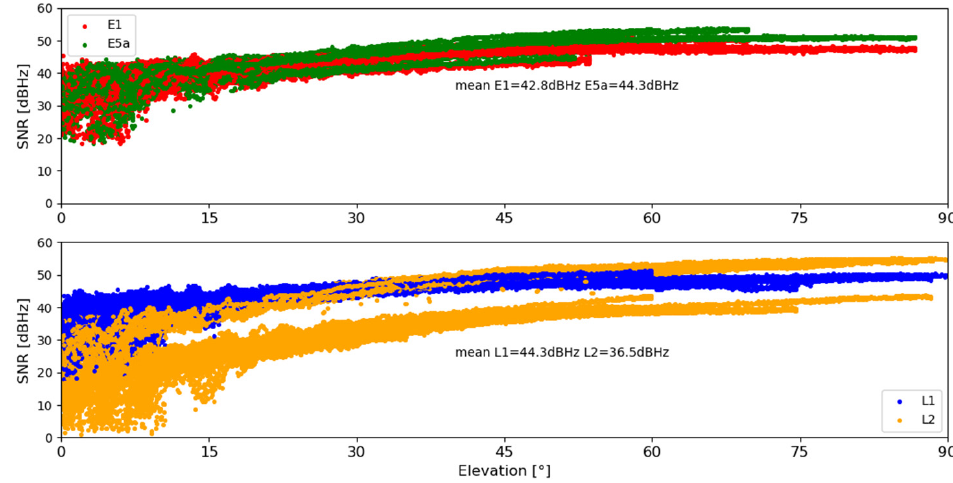
Figure 2. Signal to noise ratio (SNR) for the E1 and E5a observations for the Galileo and L1 and L2 observations for the GPS for the MAS100ESP station for the 39 DoY with function of elevation angle.